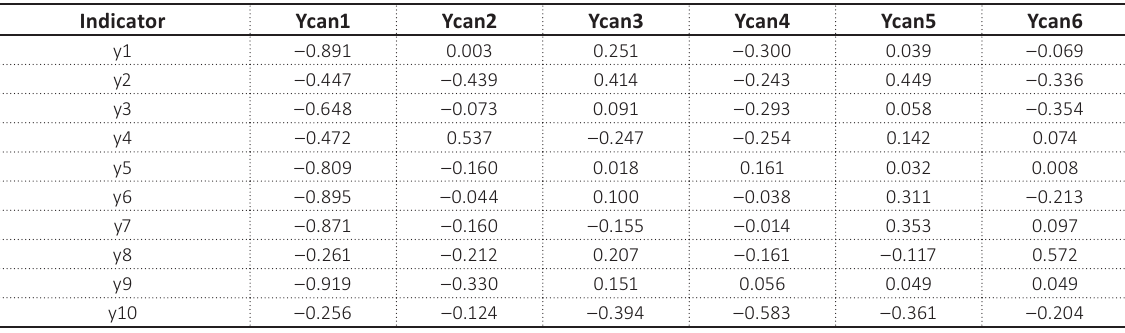
Table 7. Loading of labor market efficiency indicators